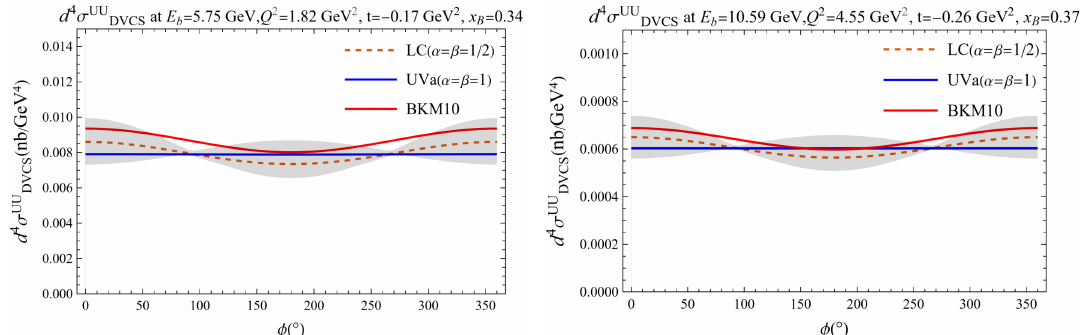
Figure 5 . Comparison of the unpolarized four-fold pure DVCS cross-section d 4 σ UU line corresponds to our light cone calculation with α = β = 1 / 2 , the blue line corresponds to our reproduced UVa result with α = β = 1 , and the red line is the BKM10 result. Besides, the gray band consists of 0 ≤ α ≤ 1 and 0 ≤ β ≤ 2 . The three results shown here are reasonably close, while their difference are higher twist